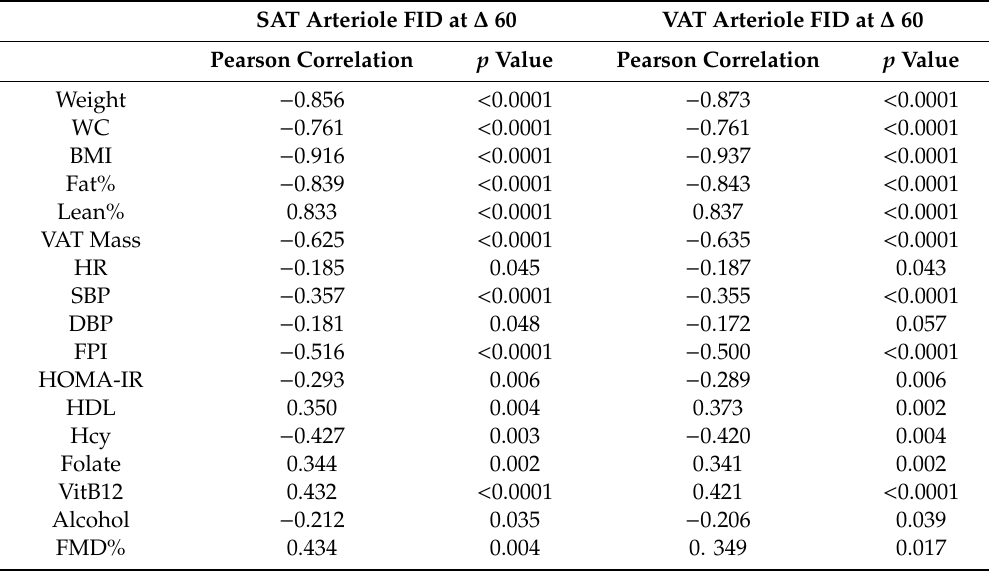
Table 2. Pearson correlations between subcutaneous (SAT) and visceral (VAT) arteriolar FID at ∆ 60 and di ff erent physical and cardiometabolic